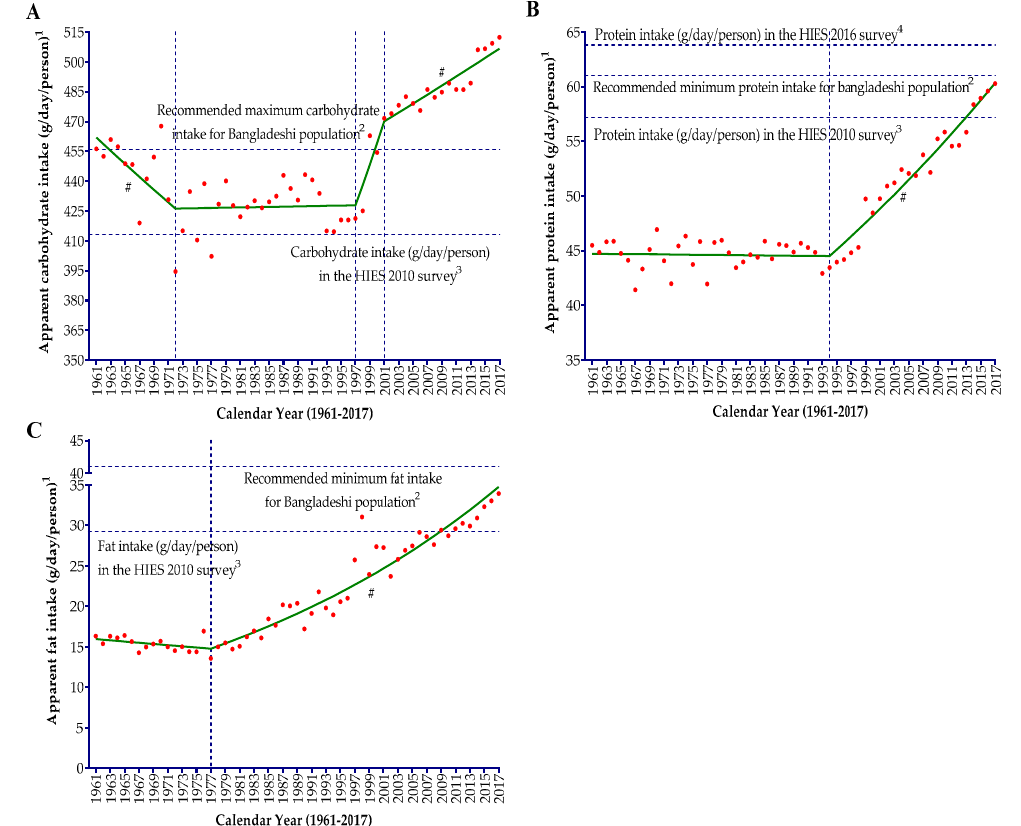
Figure 2. Joinpoint regression analysis of the apparent intakes of carbohydrate ( A ), protein ( B ), and fat ( C ) in the diets of the Bangladeshi population from 1961 to 2017. A vertical dotted line represents the joinpoints. 1 Apparent intakes of carbohydrate ( A ), protein ( B ), and fat ( C ) refer to the availability of carbohydrate ( A ), protein ( B ), and fat ( C ) in the diets for consumption in the Bangladeshi population. 2 A horizontal dotted line represents the recommended carbohydrate ( A ), protein ( B ), and fat ( C ) intakes on the basis of the desirable dietary pattern (DDP) for the Bangladeshi population [23]. 3 A horizontal dotted line represents the mean actual carbohydrate ( A ), protein ( B ), and fat ( C ) intake (g / day / person) in the diet on the basis of the H(I)ES in 2010 [23]. 4 A horizontal dotted line represents the mean actual protein intake (g / day / person) in the diet of the Bangladeshi population on the basis of the dietary analysis by the Bangladesh Bureau of Statistics (BBS) of the latest H(I)ES in 2016 [27]. # denotes the annual percent change (APC) that is significantly different from 0 ( p < 0.05).